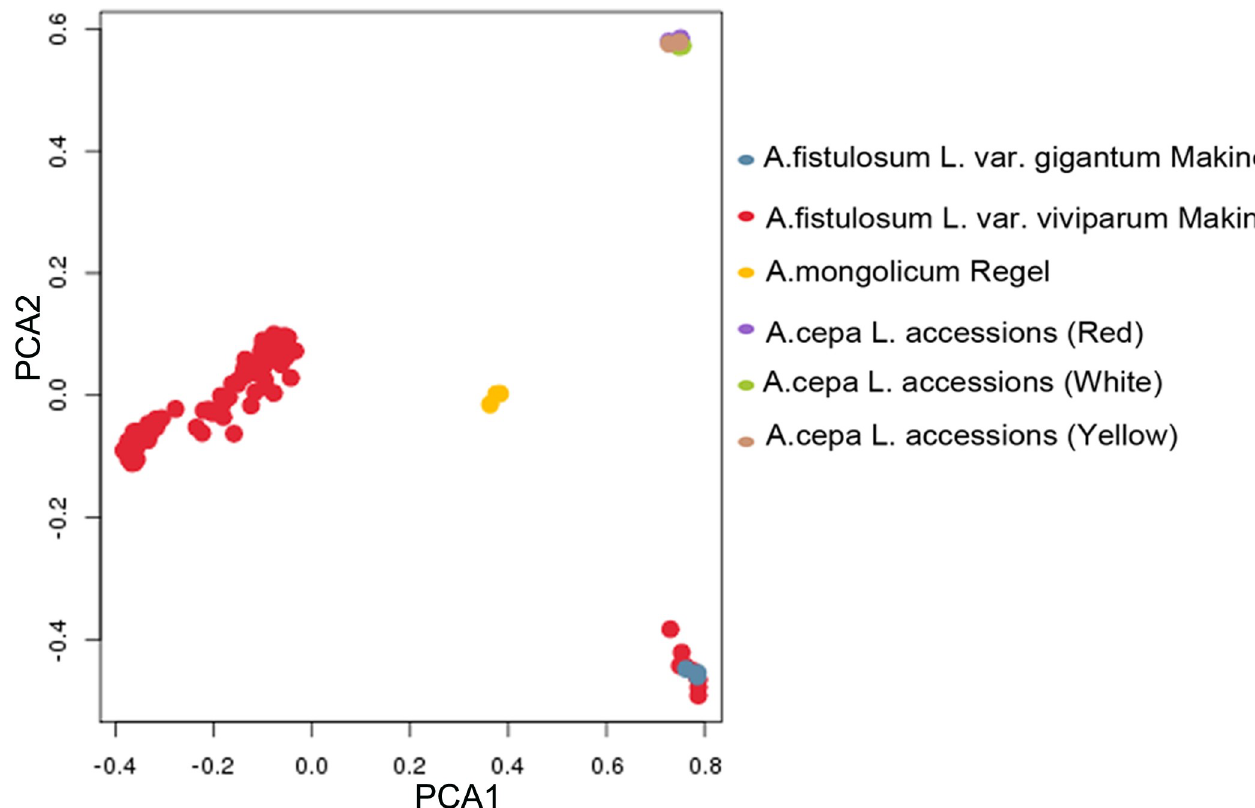
Fig 5. Principal component analysis of the 122 accessions. Different colors indicated different